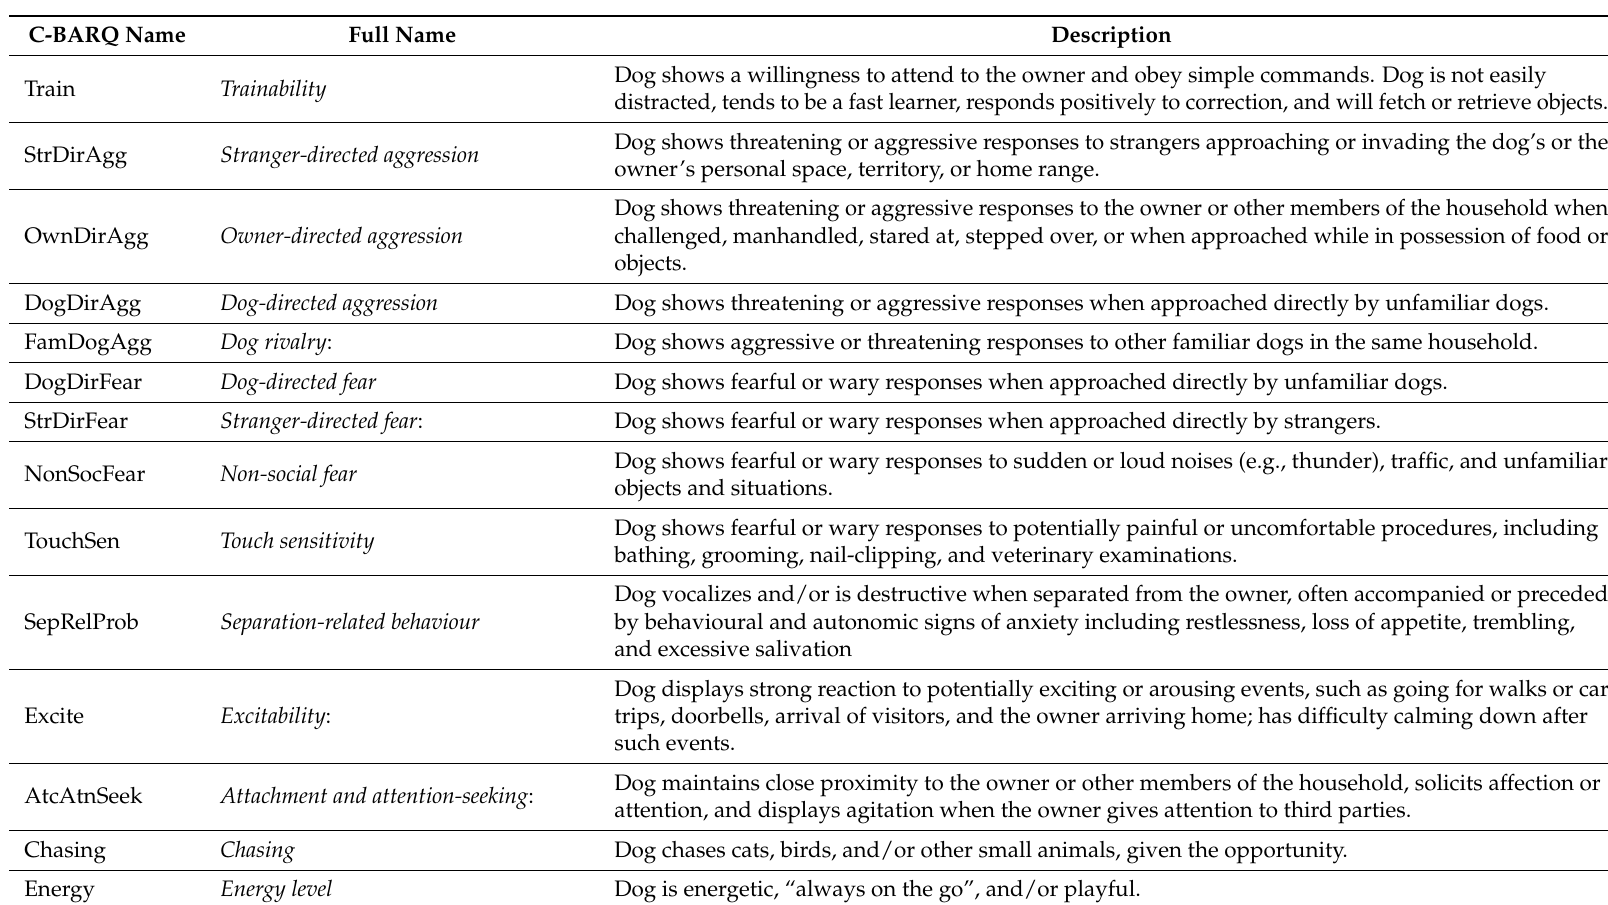
Table 1. Canine Behavioural Assessment and Research Questionnaire (C-BARQ) Behavioural